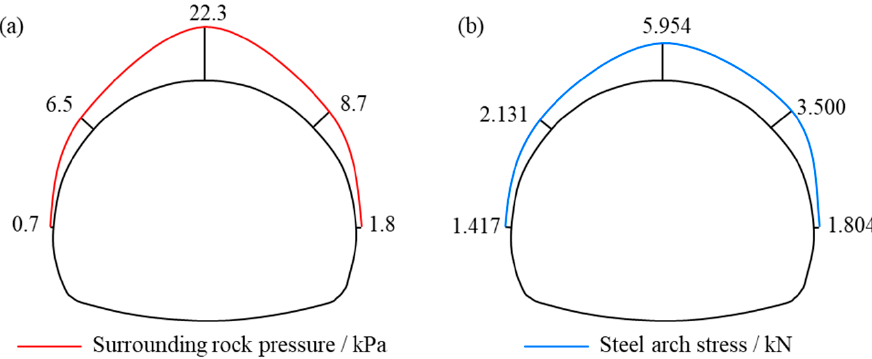
Figure 14. Stress monitoring results: ( a ) surrounding rock pressure; ( b ) steel arch stress.